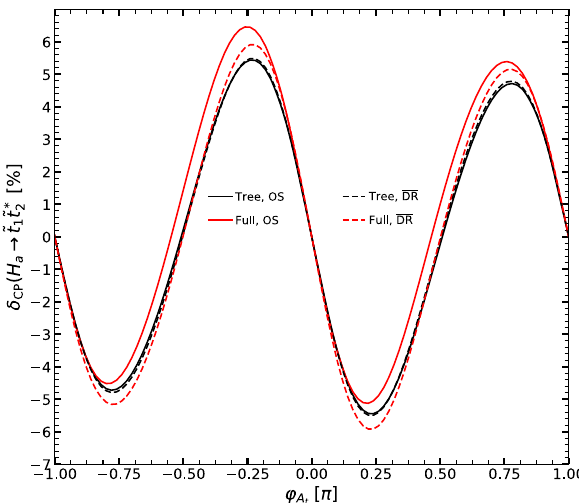
Fig. 13 CP-asymmetry δ CP as function of the complex phase ϕ A tree level (black) and including both the EW and the QCD corrections (red) in the DR (dashed) and OS (full)